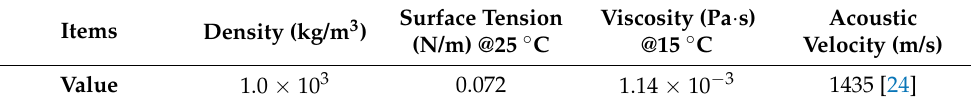
Figure 1. ( a ) Schematic of experimental setup; ( b ) schematic of nozzle. Table 1. Physical properties of deionized water.